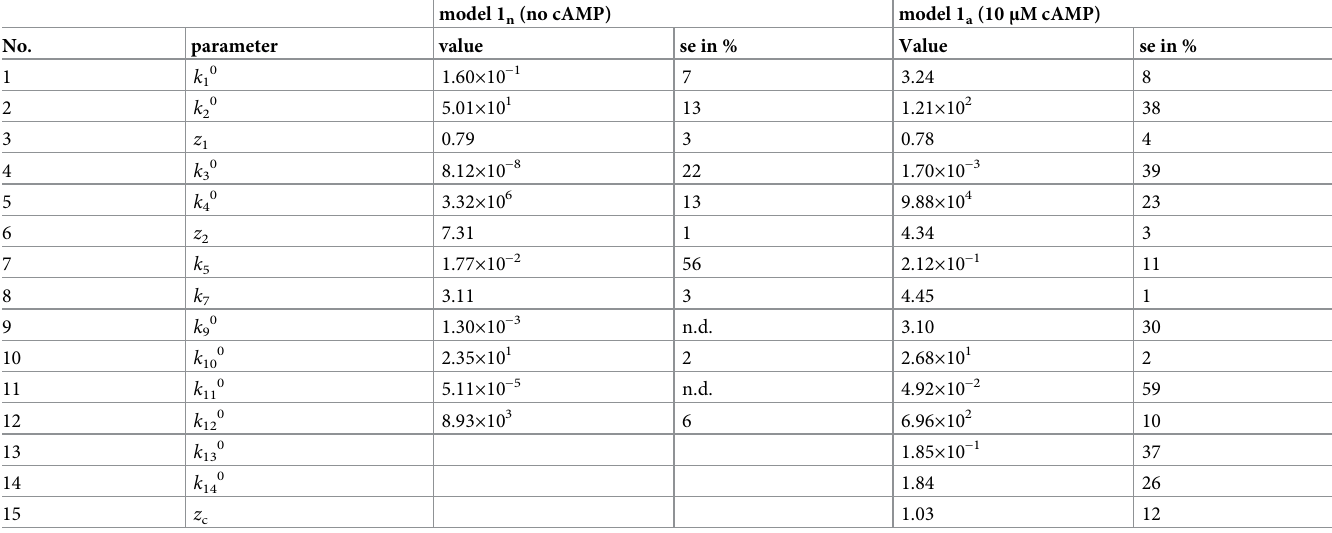
Table 1. Parameters for the fits with models 1 n (no cAMP) and 1 a (10 μ M